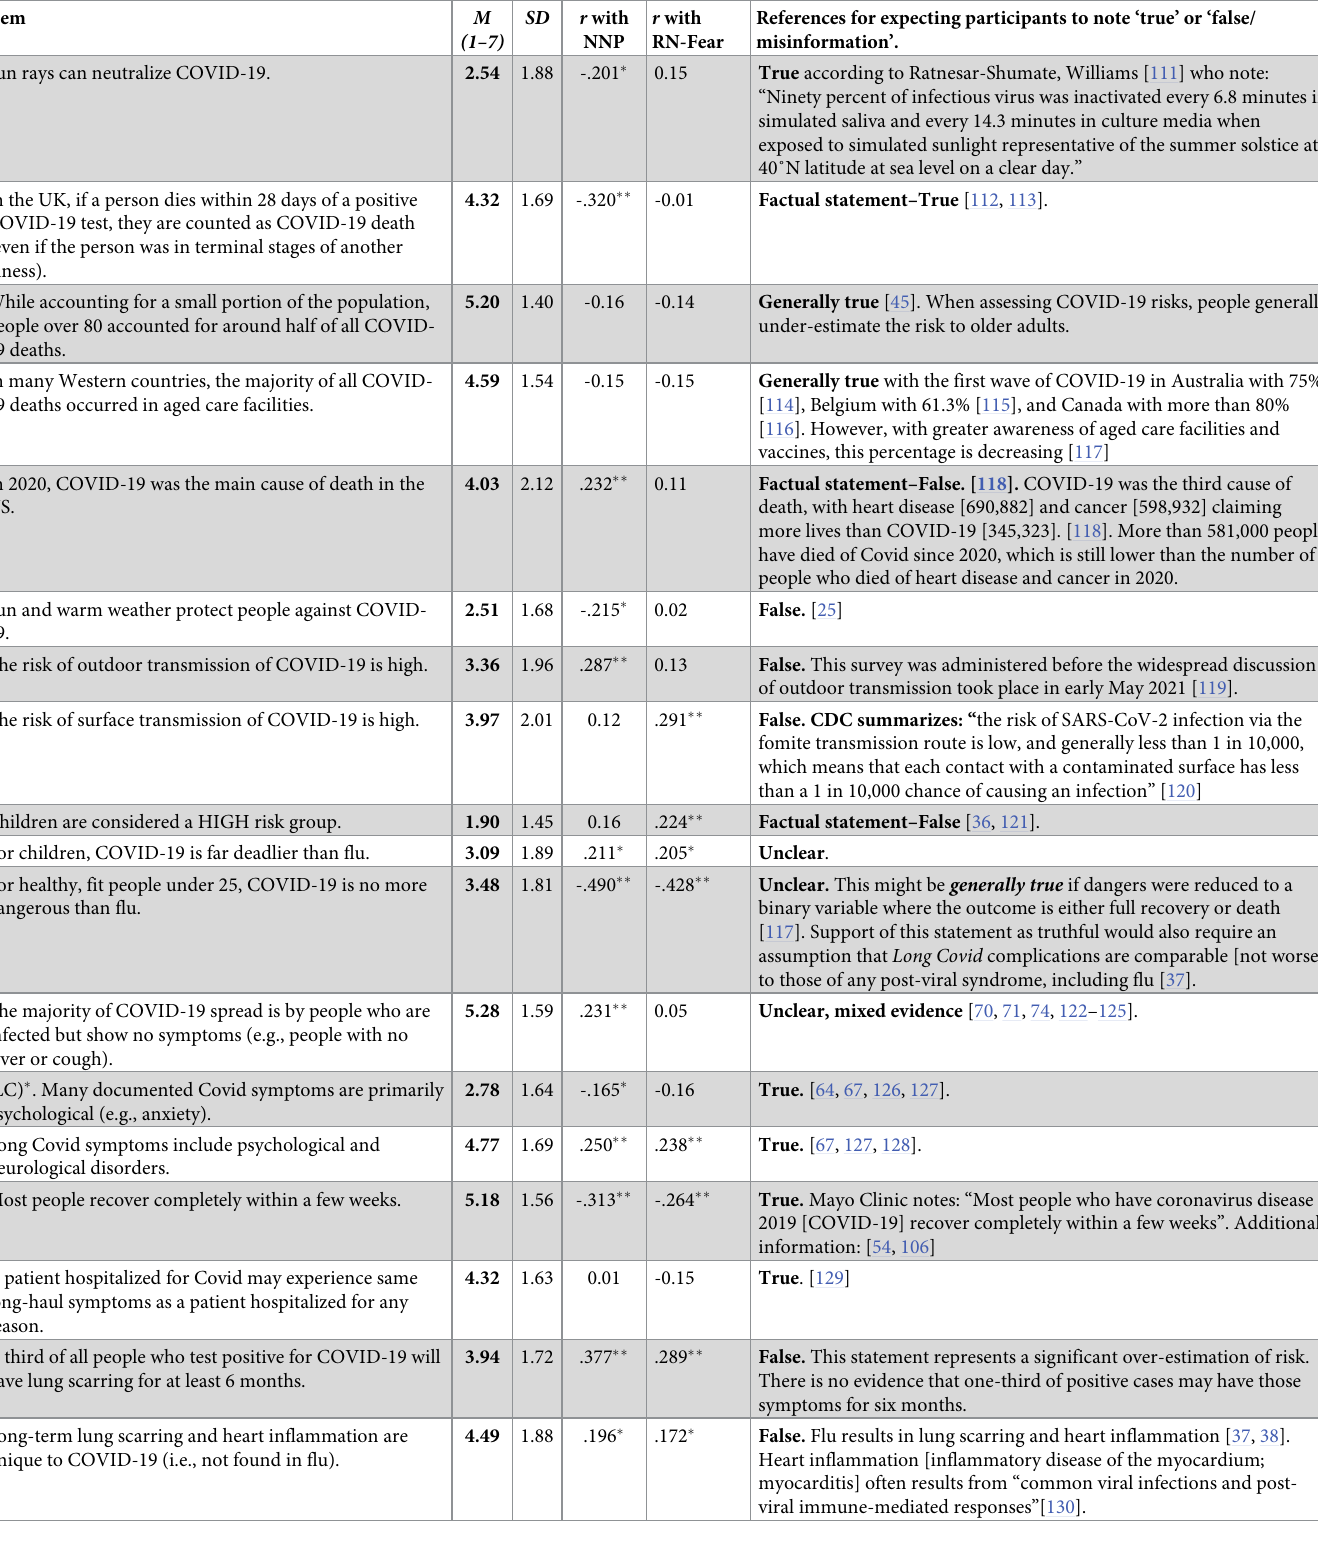
Table 14. NNP and relationship with knowledge questions in Samples A and B.